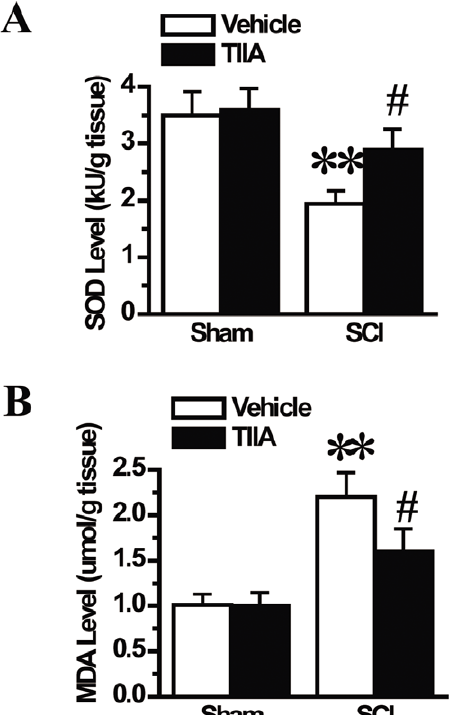
Figure 10. Effects of TIIA on oxidative stress markers after SCI. SCI induced the decrease of SOD activity at 24 h after SCI, but treatment with TIIA increased SOD 65 activity (A). The MDA level was significantly increased in the tissues from the SCI group at 24 h after SCI. TIIA treatment inhibited SCI-induced increase in MDA level (B). Bars represent means 6 SEM. ** p , 0.001 vs. sham group, # p , 0.05 vs. SCI group.